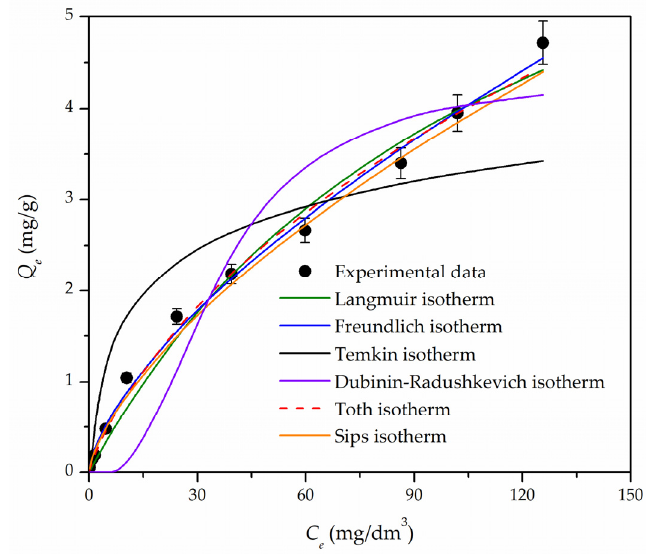
Figure 7. Nonlinear fitting curves for the adsorption isotherms of chromium onto Fe 3 O 4 @APTMS/PGME-deta sorbent. Error bars represent the standard error of three replicates.